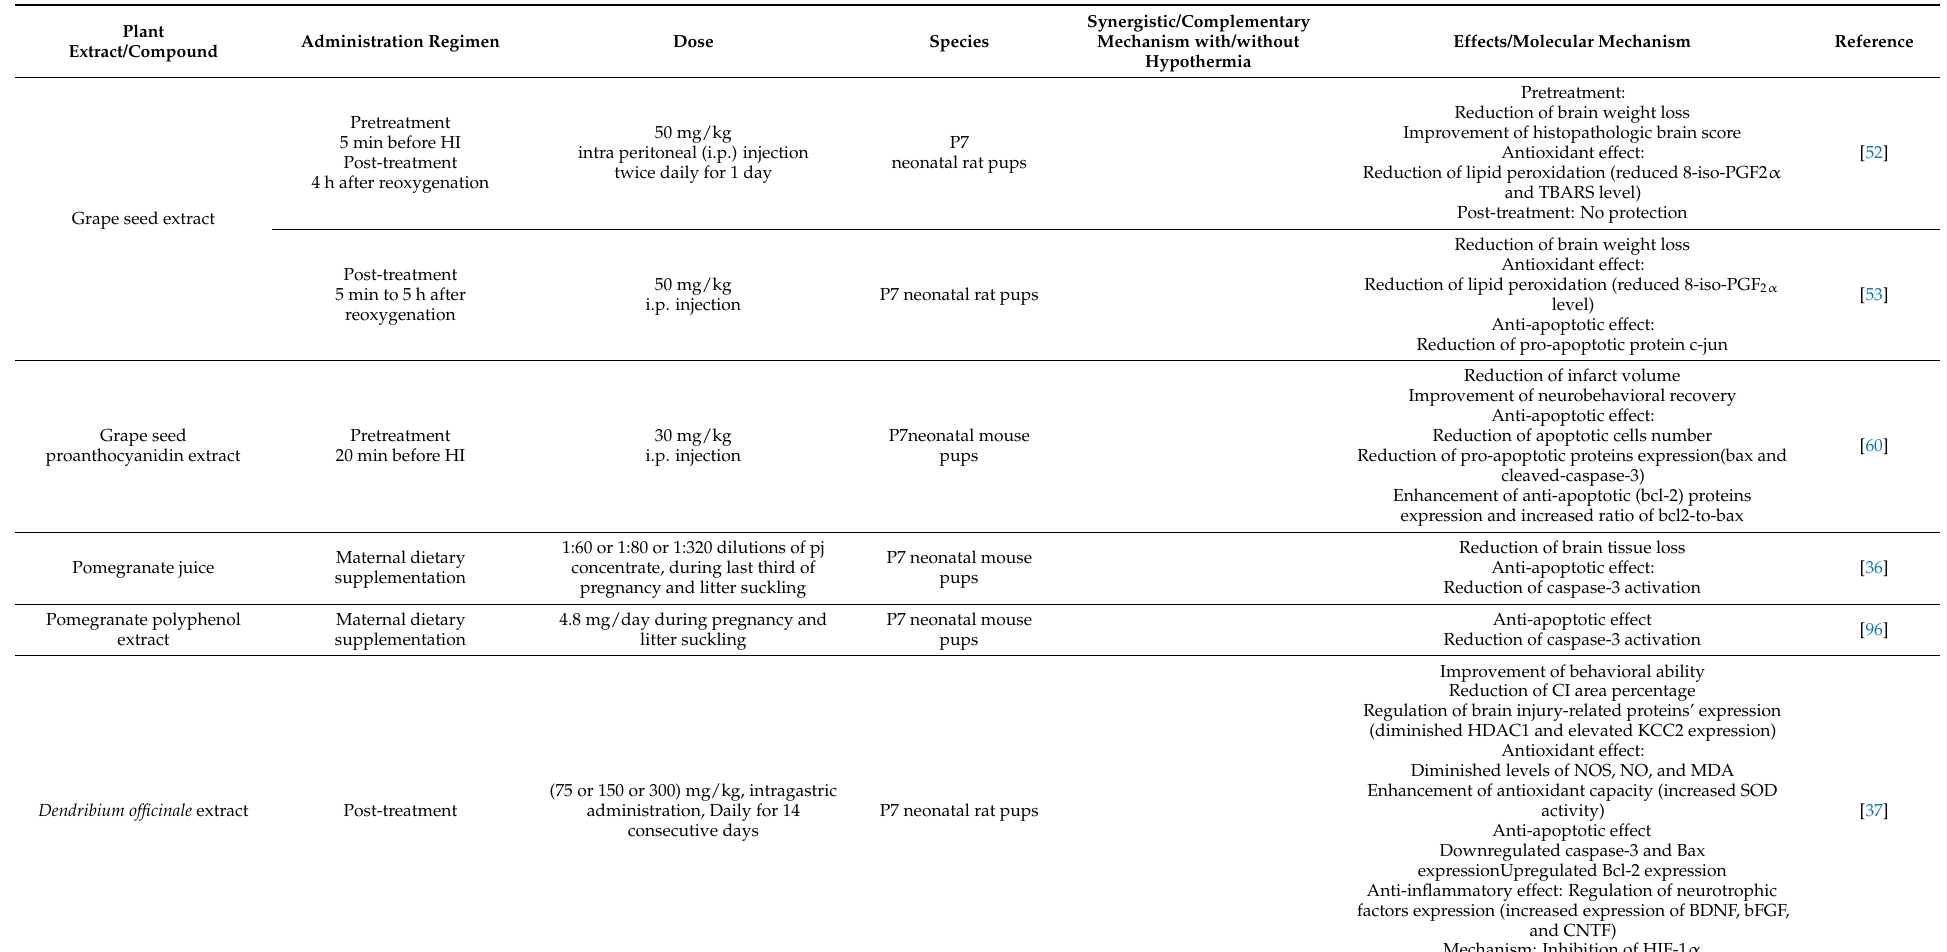
Table 1. The studied plant extracts/plant-derived compounds in animal models of neonatal hypoxic-ischemic brain